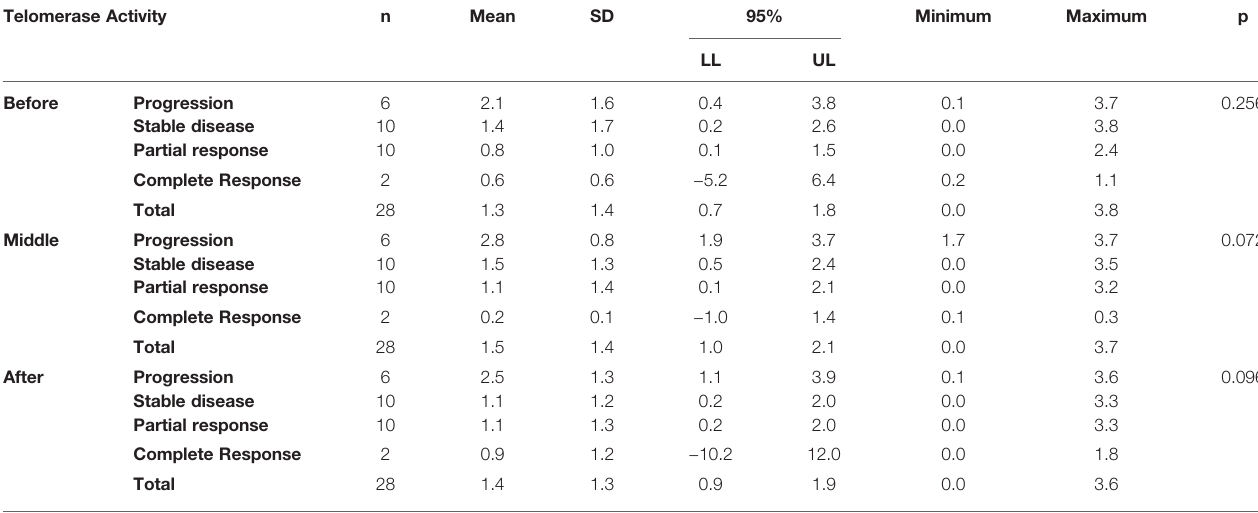
p-values were estimated with Kruskal – Wallis test. n, number of patients.